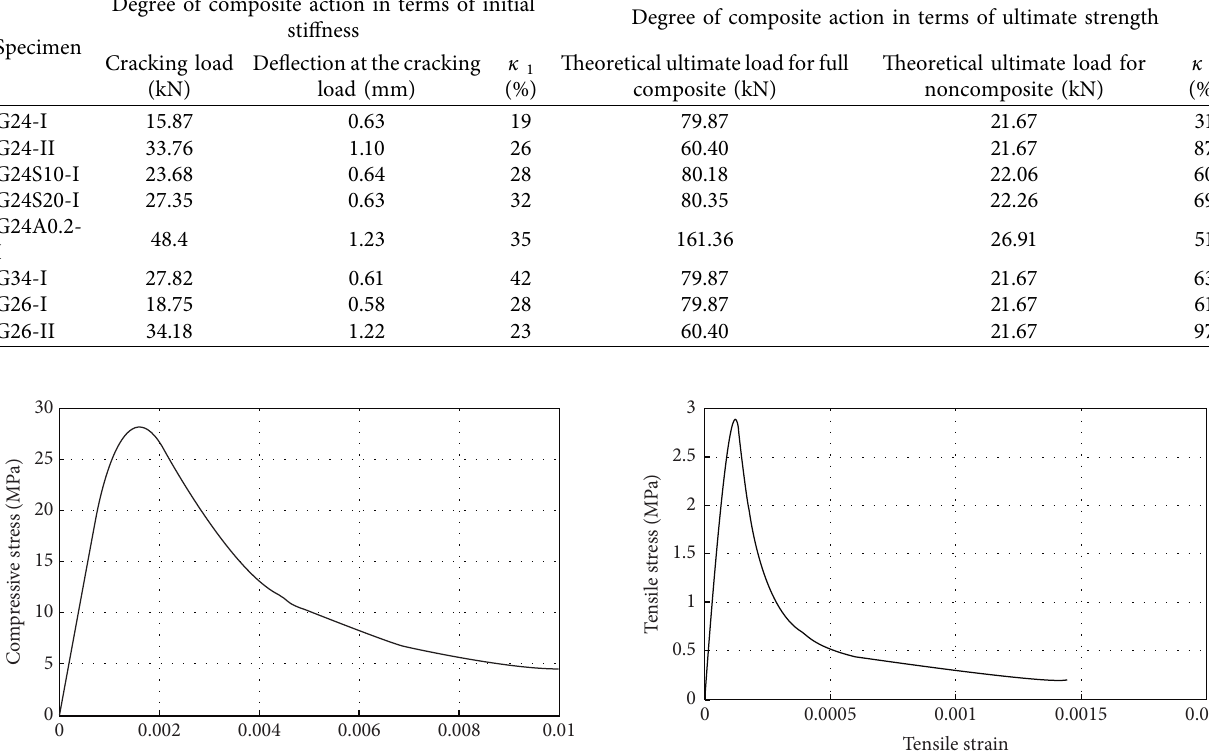
Table 5: Degree of composite action.